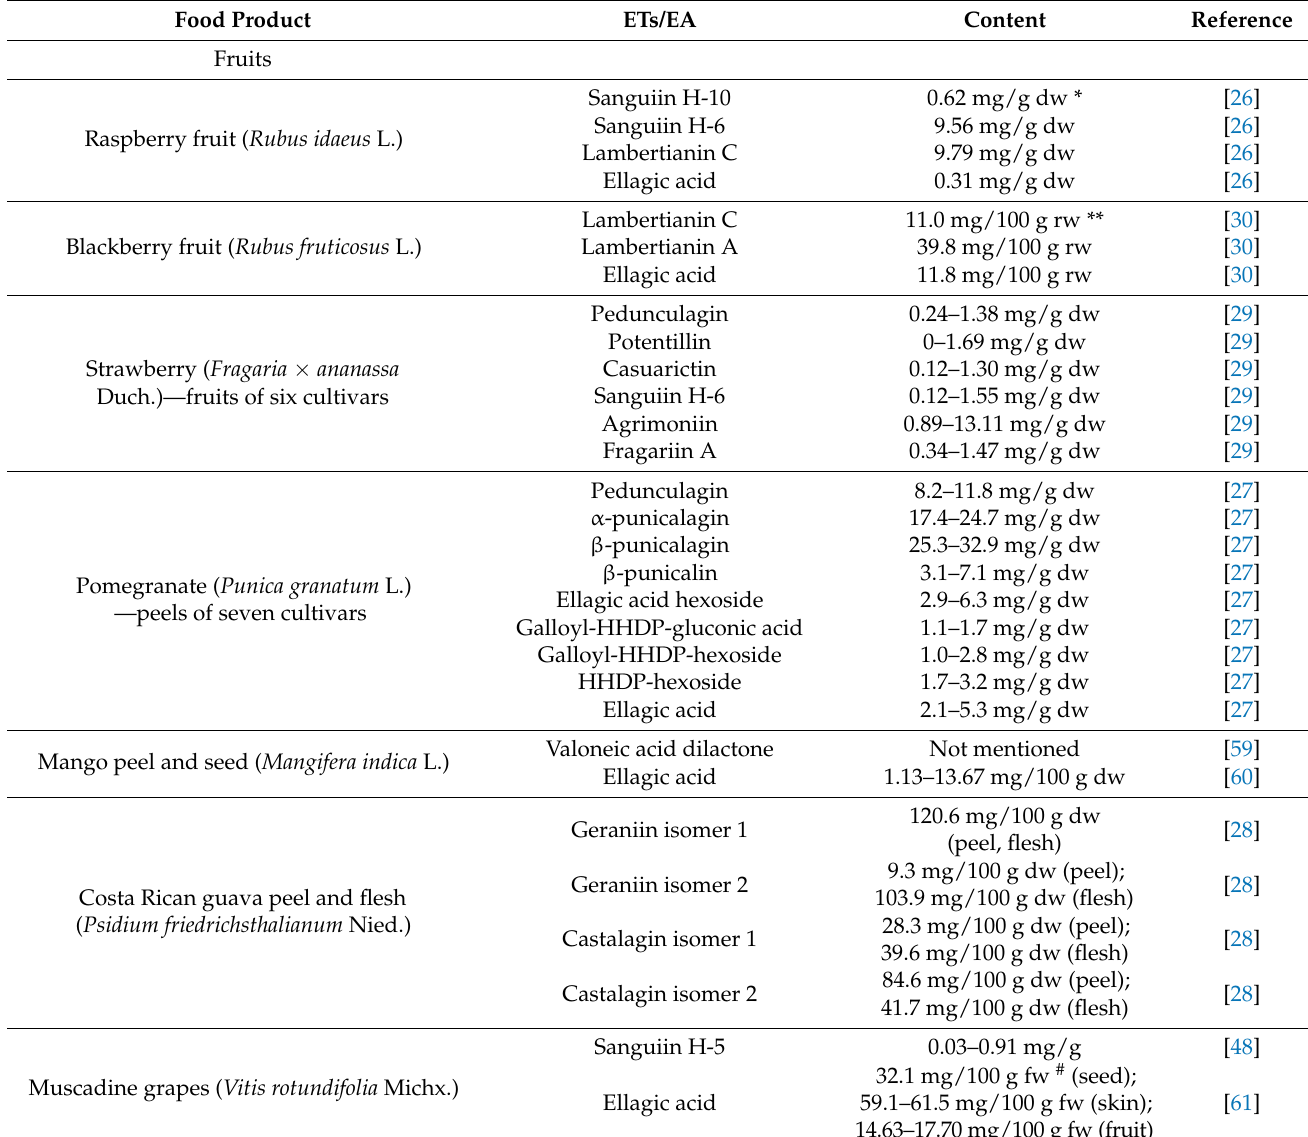
Table 1. Contents of ellagitannins and ellagic acid in fruits, nuts, and